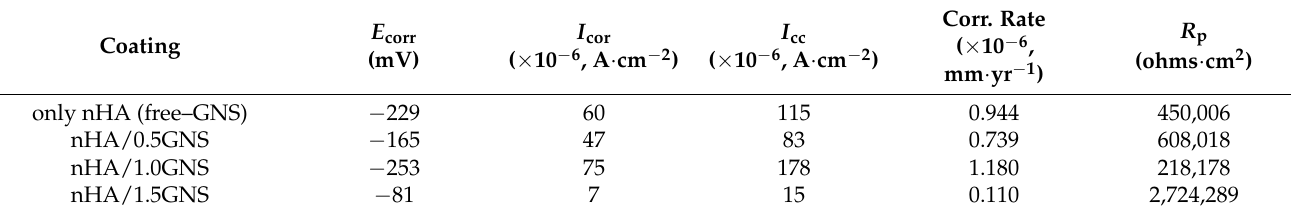
Figure 9. ( a ) The PDS graph of nHA/GNS hybrid coatings and ( b ) illustration of determining cathodic current density ( I corr ) from Tafel plot. Table 4. Corrosion parameters calculated from PDS curves of the coatings